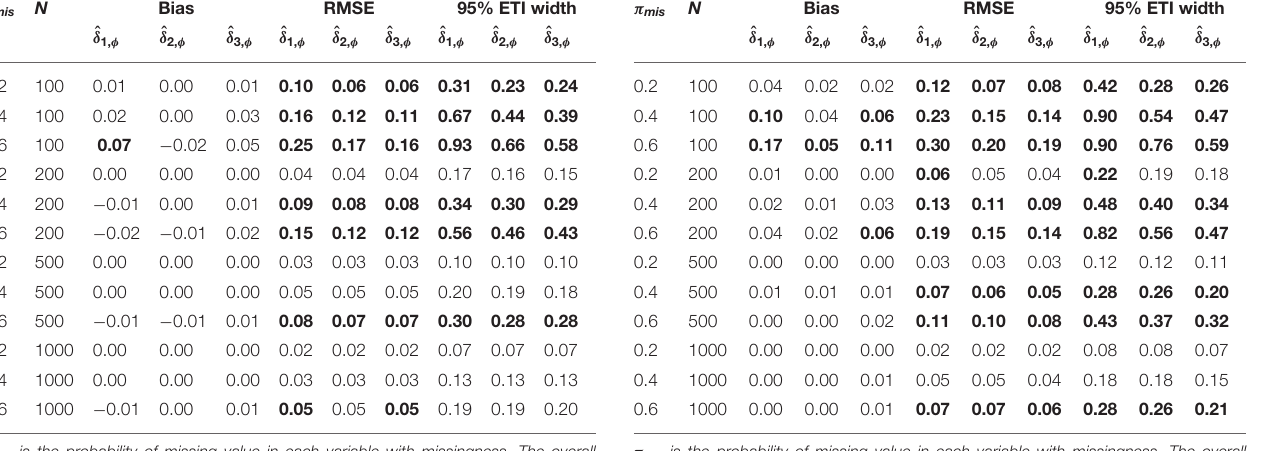
TABLE 5 | The bias, RMSE, and the 95% equal-tailed interval width of factor correlation FMIs under nonlinear MAR. π mis N Bias RMSE 95% ETI width ˆ δ 1,